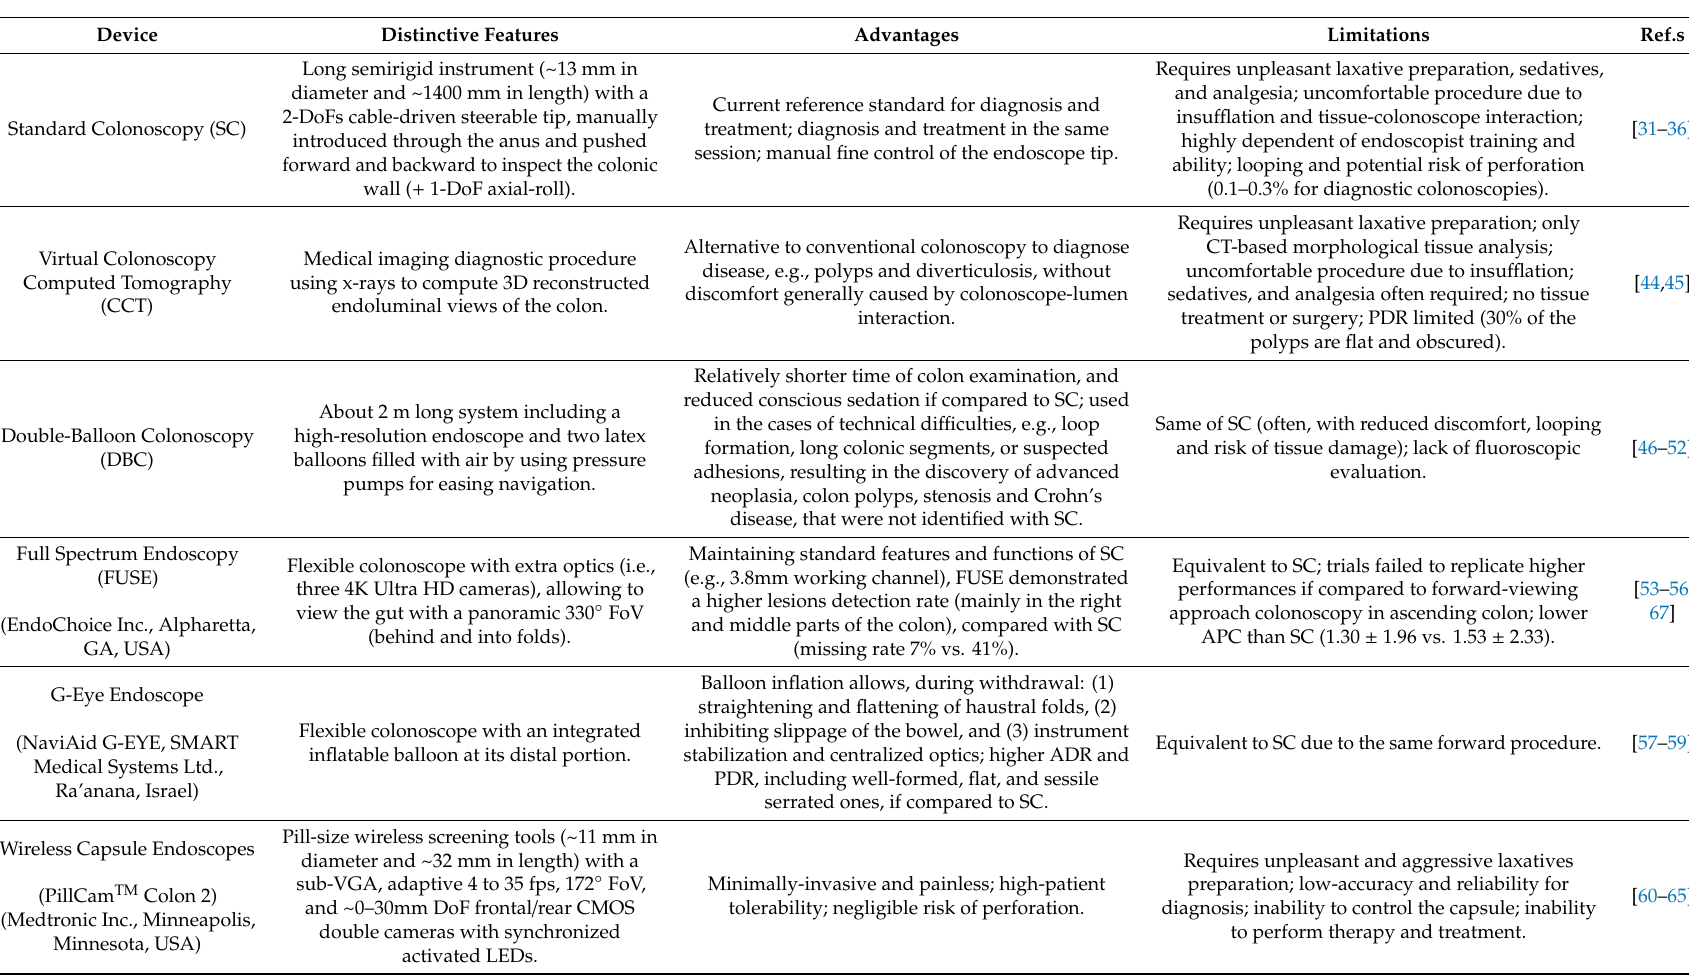
Table 1. Summary of the distinctive features, advantages, and limitations of non-robotic colonoscopes and colonoscopy adjuncts, available in the clinical